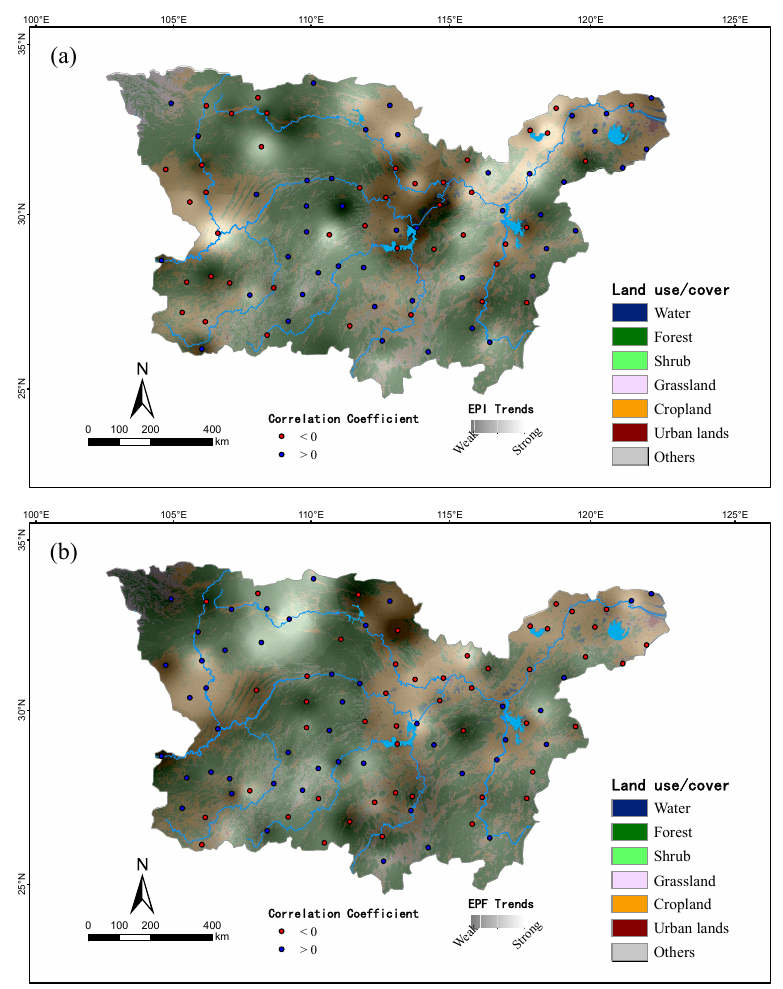
Figure 6. Vegetation-type-based analysis of the correlations between maximum NDVI and ( a ) extreme precipitation intensity and ( b ) extreme precipitation frequency.